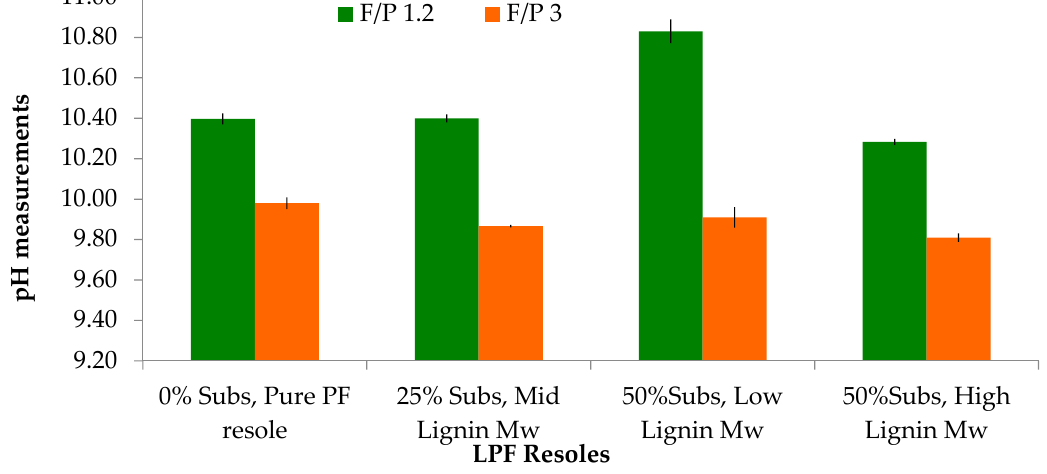
Figure 2. pH of phenolic resoles with varying F/P ratios for pure PF resoles and BPFs at 25% and 50% phenol substitutions.